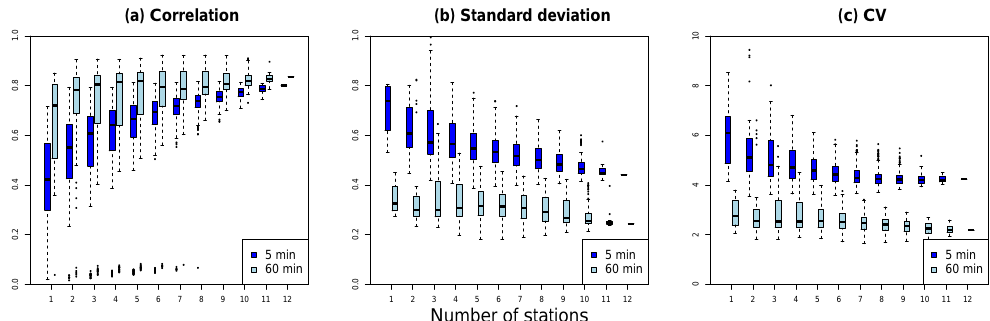
Figure 10. Box plots of correlation, standard deviation and coefficient of variation of residuals (CV) of averaged rainfall intensity time series. The box plots contain the outcomes for all possible subsets within the 12 stations in the Amsterdam city center, as compared to the gauge-adjusted radar rainfall intensity 20-pixel mean for interpolated 5min and hourly time